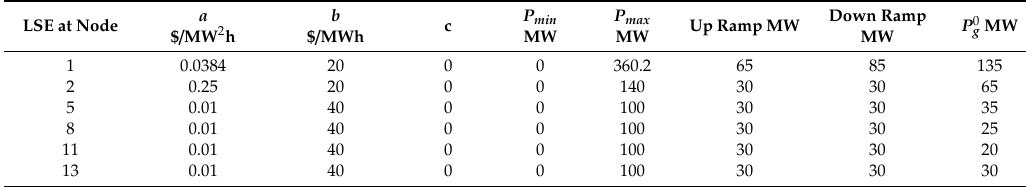
Table A1. LSE cost coe ffi cient profile of modified IEEE 30 bus system.